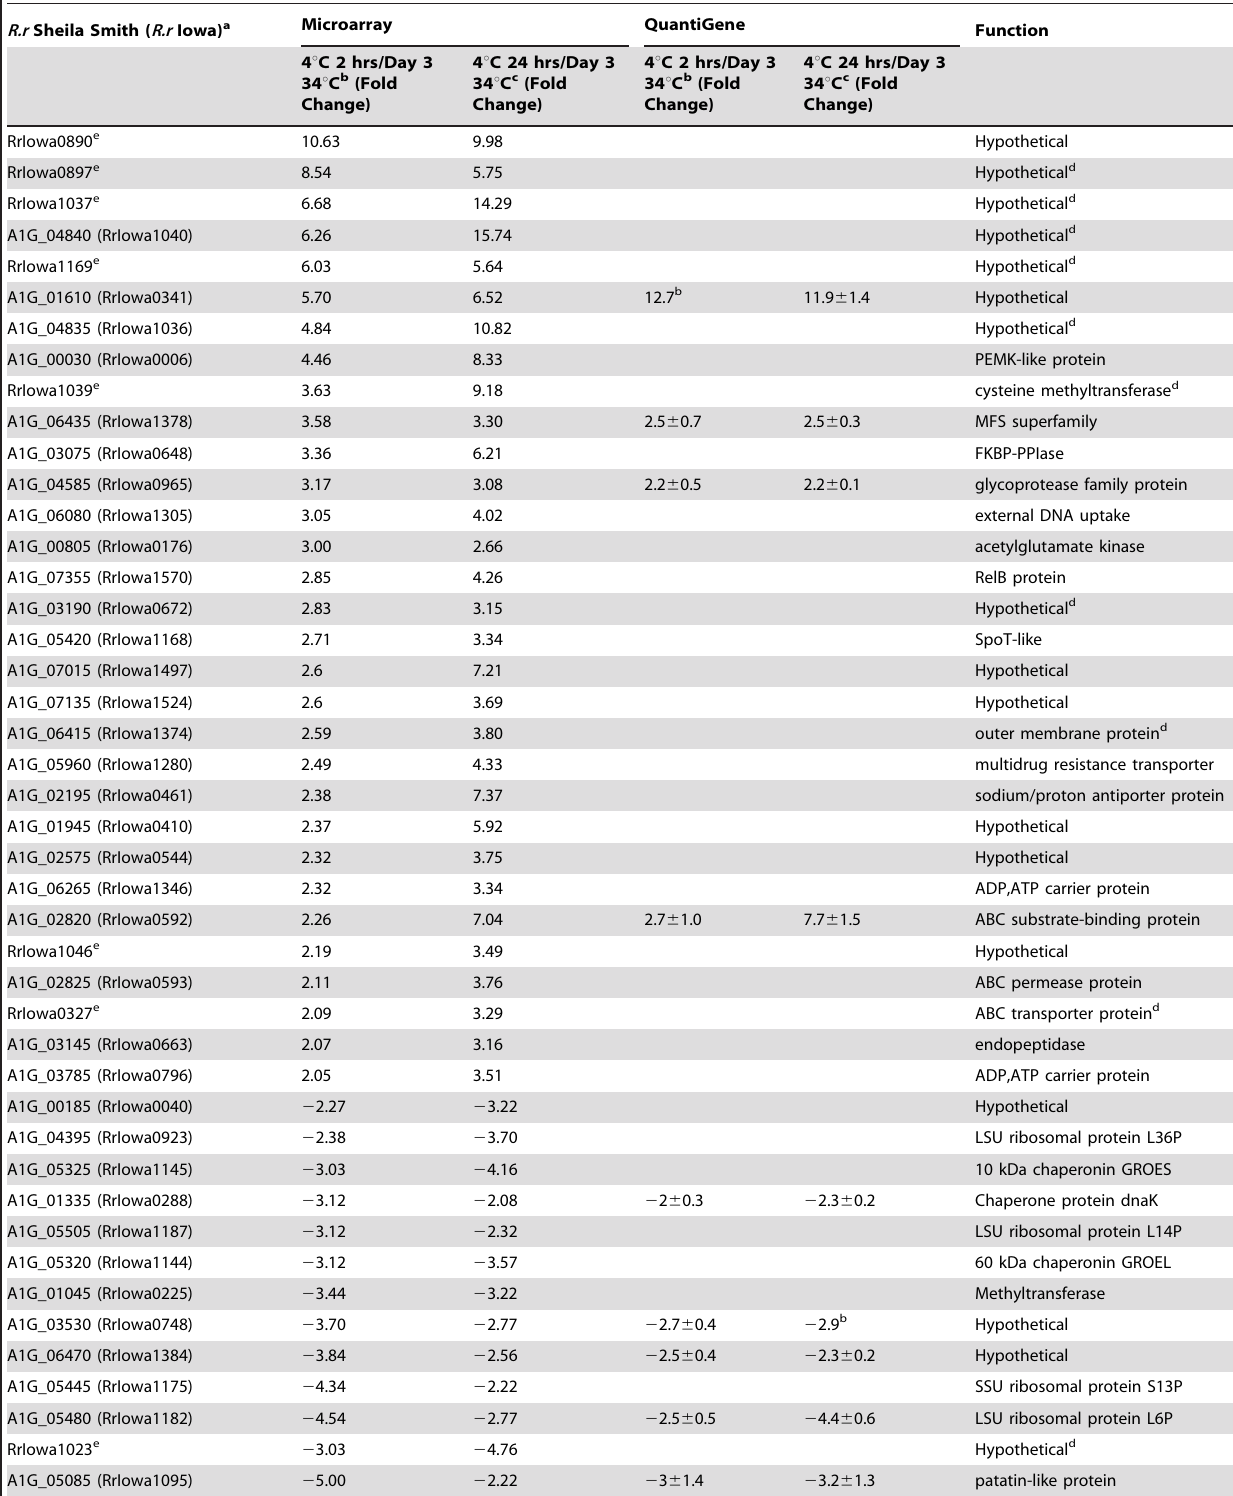
Table 3. Confirmation and comparison of responses after 2 and 24 hrs at 4 u